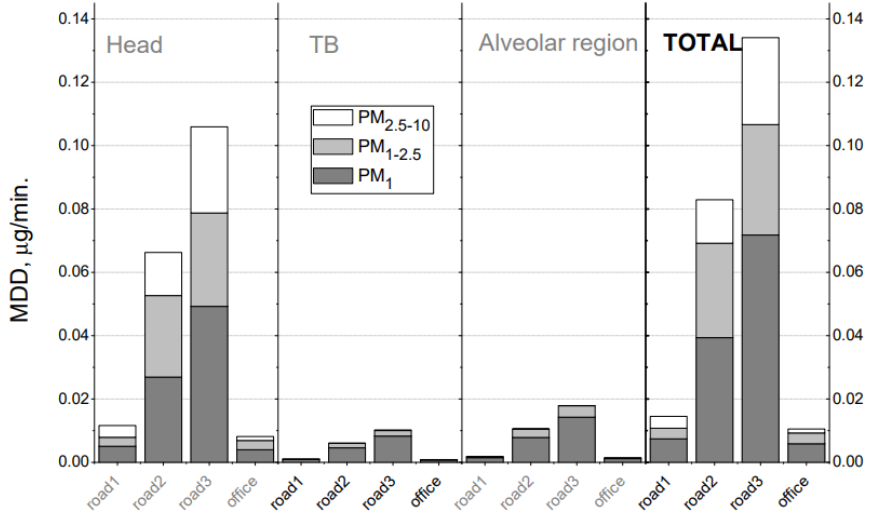
Figure 7. Contributions of PM fractions (PM <1 , PM 1–2.5 , and PM 2.5–10 ) to total deposition dose in URT, TB, and alveolar regions calculated with the MPPD model for different routes (“read1-3” corresponds to cases presented in Table 1) and for the modern office.